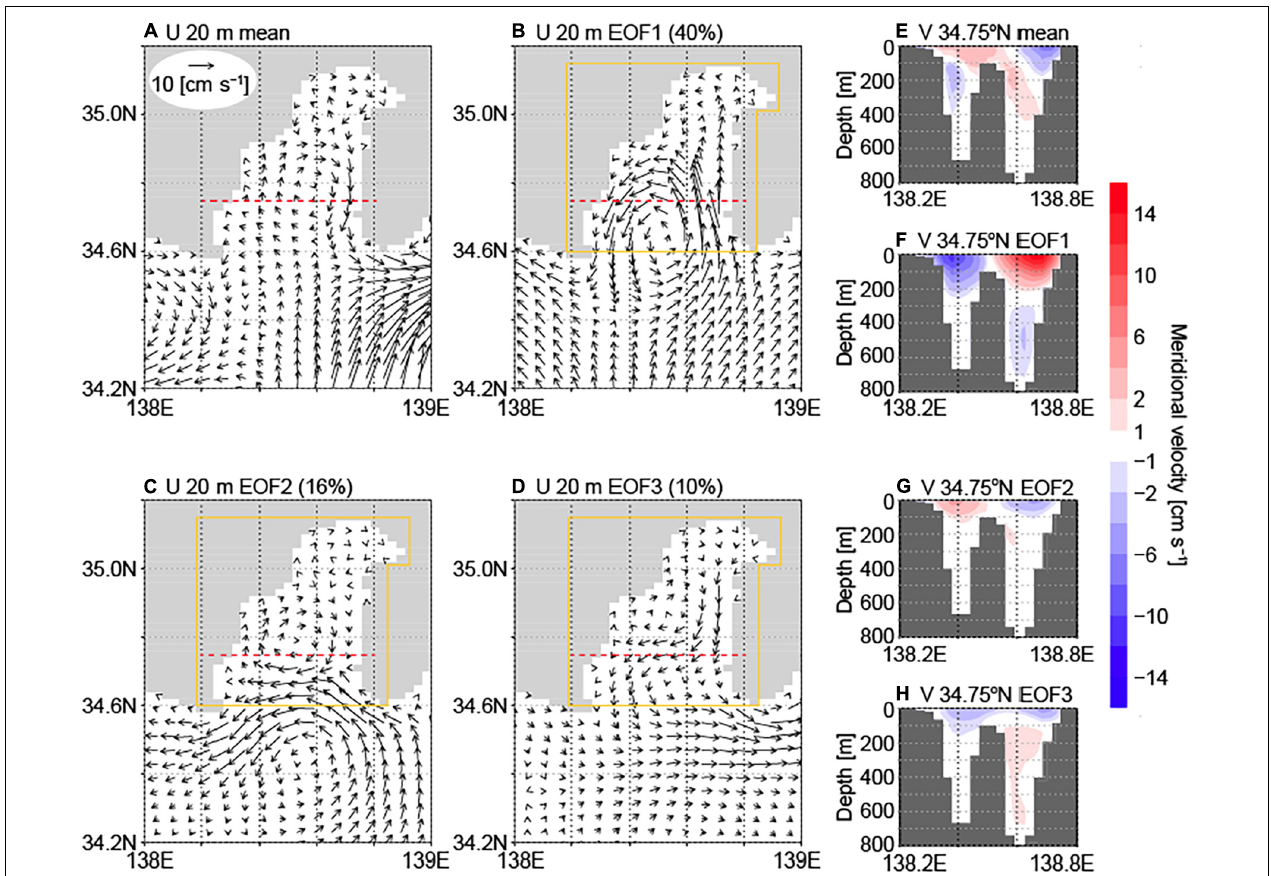
FIGURE 3 | (A–D) Distributions of horizontal velocities at 20 m depth. (E–H) Distributions of the meridional velocities on the vertical cross section along the 34.75 ◦ N line as indicated by red dashed lines in (A–D) . (A,E) Long-term mean field averaged over the product period 2008–2019. (B,F) EOF1. (C,G) EOF2. (D,H) EOF3. EOF analysis was conducted for the 20 m velocities in Suruga Bay (inside yellow lines) and projections to the EOF time series were plotted in the other region for (B–D,F–H)